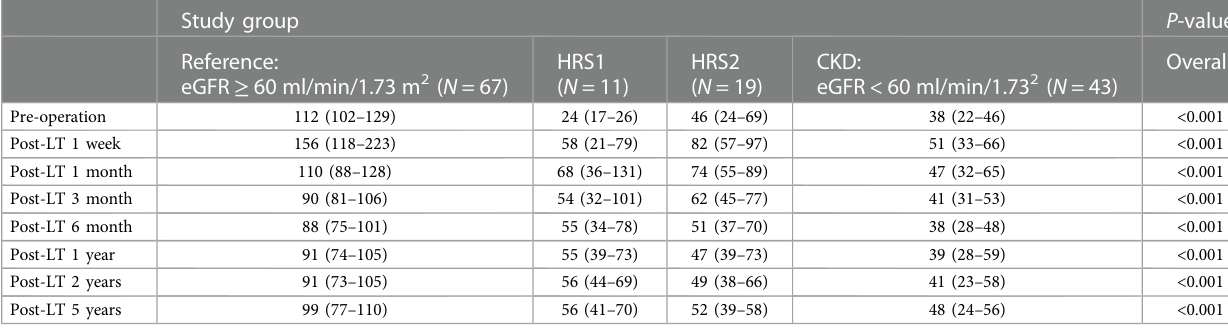
TABLE 4 Series of eGFR (ml/min/1.73 m 2 ) after LDLT in four groups strati fi ed by preoperative renal function. Study